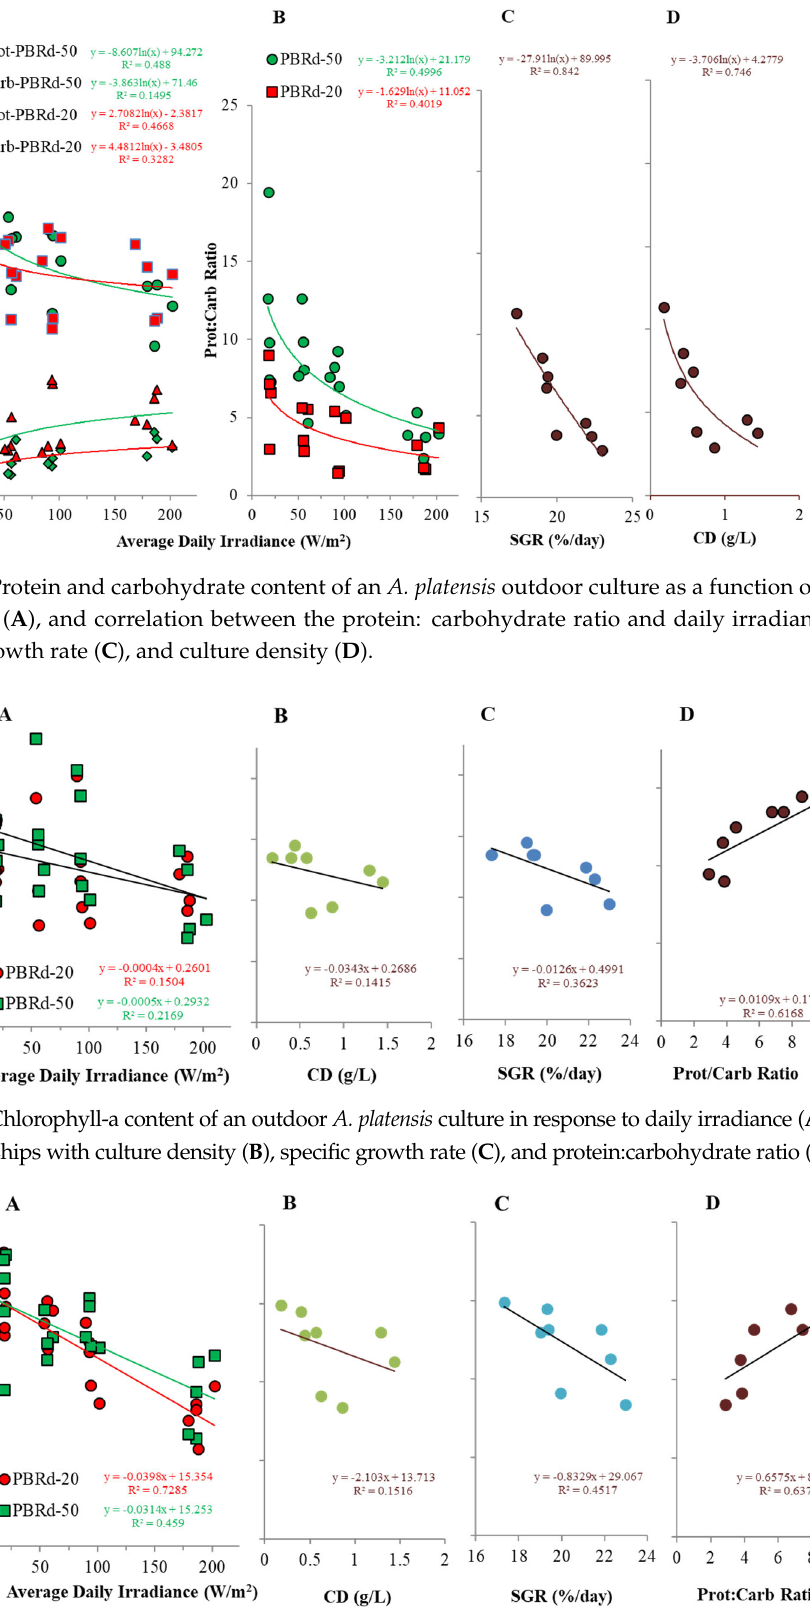
Figure 7. C ‐ phycocyanin content of an outdoor A. platensis culture in response to daily irradiance ( A ), and its correlations with culture density ( B ), specific growth rate ( C ), and protein:carbohydrate ratio ( D ).